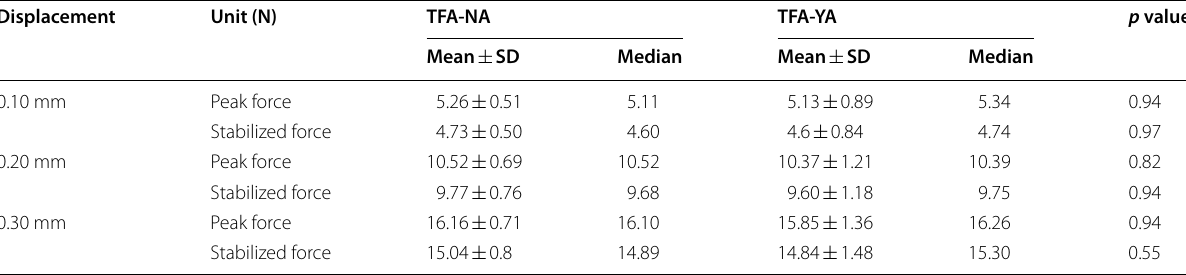
Table 1 Comparing TFA-NA (no attachments) and TFA-YA (with attachments)